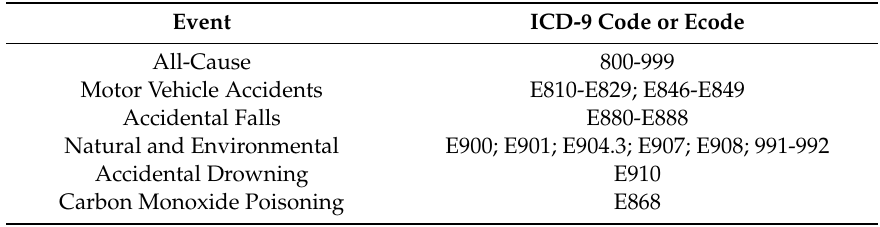
Table 1. Emergency codes (Ecodes) and ICD-9 codes used to create injury